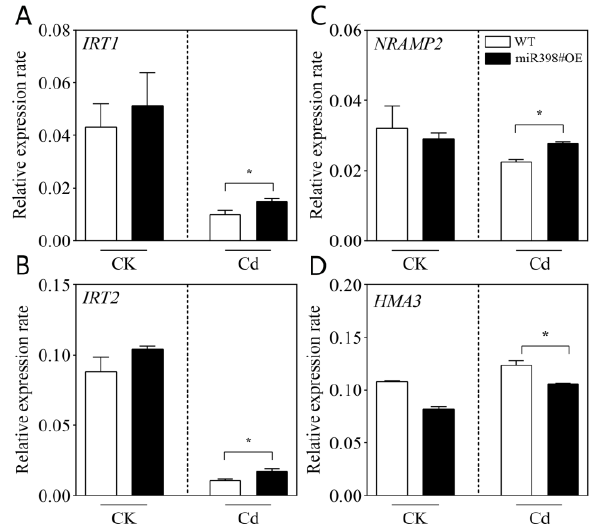
Figure 6. Relative expression rates of IRT1 ( A ), IRT2 ( B ), NRAMP2 ( C ), and HMA3 ( D ) in the root of wild type (WT) and transgenic line overexpressing MIR398 (miR398#OE) under cadmium stress. Tomato seedlings (25 d old) of WT and miR398#OE were grown under control (CK) and 100 μM Cd(NO 3 ) 2 (Cd) for 9 d. The data are the mean values + SD of four individual replicates. Asterisks indicate significant difference between WT and miR398#OE ( p < 0.05).